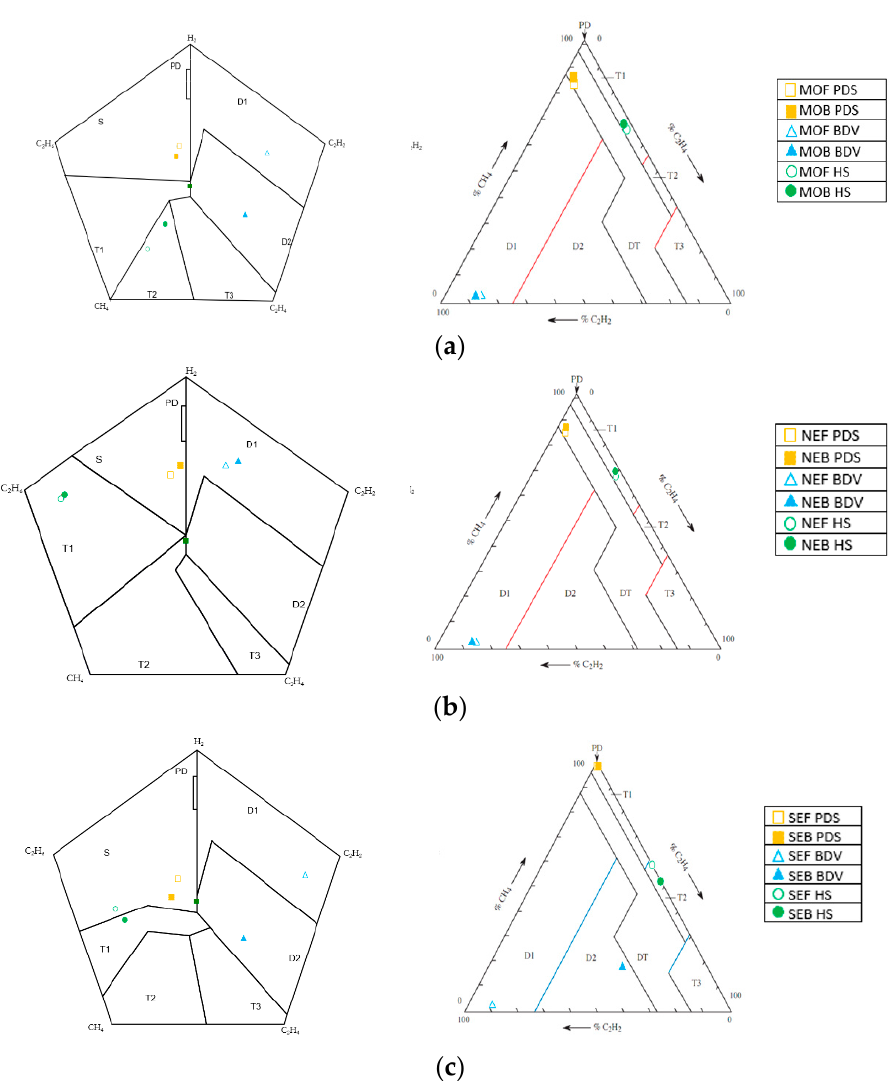
Figure 6. Illustration of fault gas diagnosis using Duval’s pentagon and Duval’s triangle methods; ( a ) mineral oil; ( b ) synthetic ester; ( c ) natural ester.